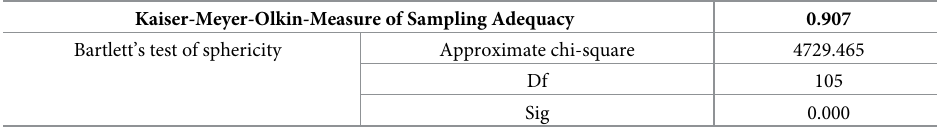
Table 3. KMO and Bartlett’s test.